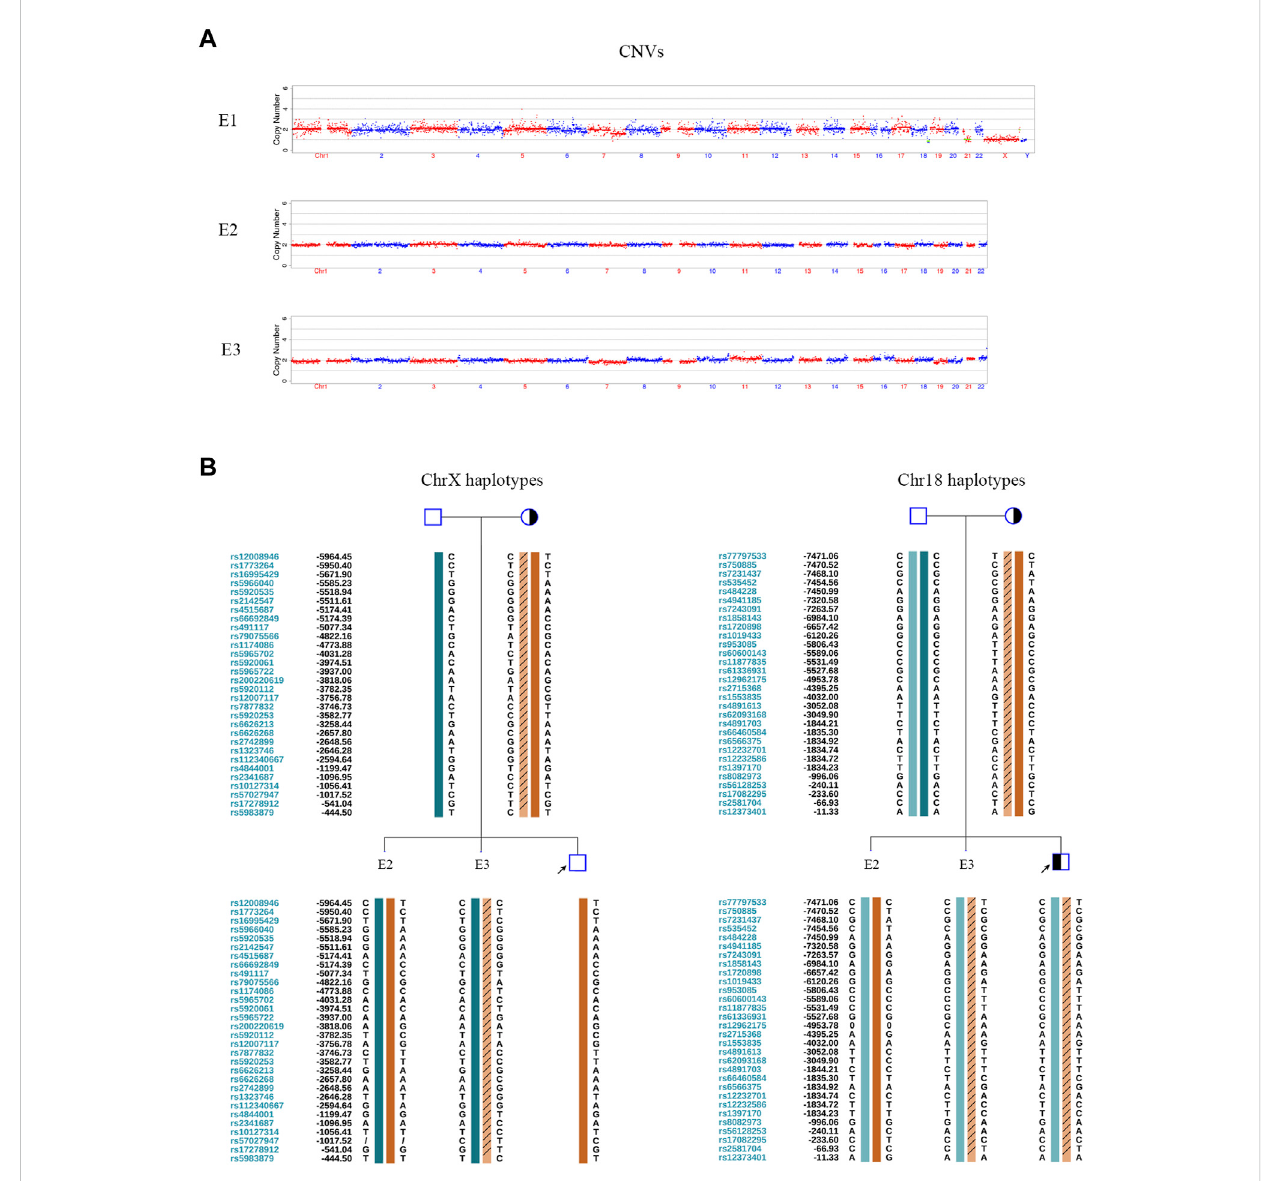
FIGURE 3 CNV tests and SNP-based linkage analysis for RecT detection in embryos. (A) Embryonic CNV results. E1 was unbalanced. E2 and E3 were chromosomally balanced. (B) Pedigree haplotyping around chromosomal breakpoints. The interpretation of symbols and bars is explained in the legend of Figure 1C. E2 inherited its two wild-type X chromosomes and two wild-type 18 chromosomes from their parents. It was female and free of RecT. E3 inherited a derivative ChrX and derivative Chr18 from the mother. It carried RecT between ChrX and